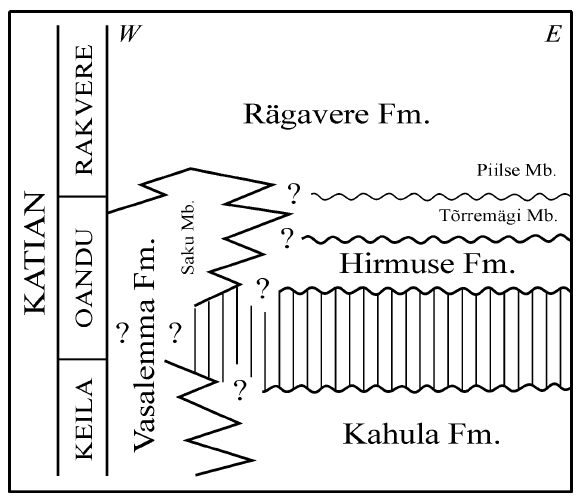
Fig. 2. Stratigraphy of the upper Keila, Oandu and lower Rakvere stages in North Estonia (modified from Ainsaar et al. 2004 and Kröger et al. 2014b). In this paper, the term ‘Stage’ is used in traditional for Estonia sense (e.g. Meidla et al. 2014). In Estonia, the stages are distinguished based on their content (characteristic lithology and faunas) and, as a rule, no boundary stratotypes are defined. From left to right: global stage; regional stage; probable relationship of formations and members on the western–eastern transect. Wavy lines correspond to discontinuity surfaces, vertical ruling to a gap (precise duration unknown). Question marks indicate that lateral relationships of units and the position of their boundaries are problematic. Abbreviations: W , West; E , East; Fm., Formation; Mb., Member.